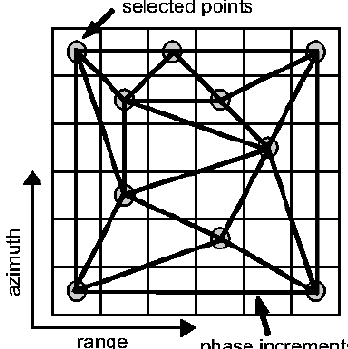
Figure 2 . Points connection. The selected pixels are connected by edges (Mora, 2003).